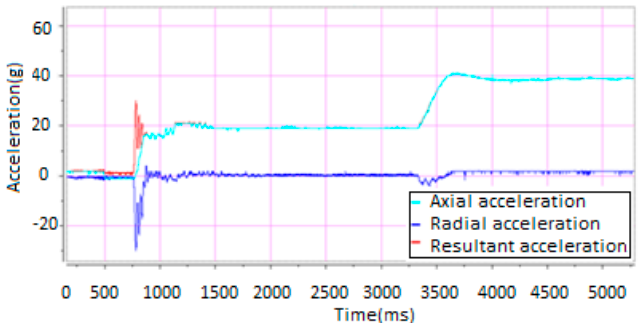
Figure 11. 2-D acceleration test results for the unit being tested .